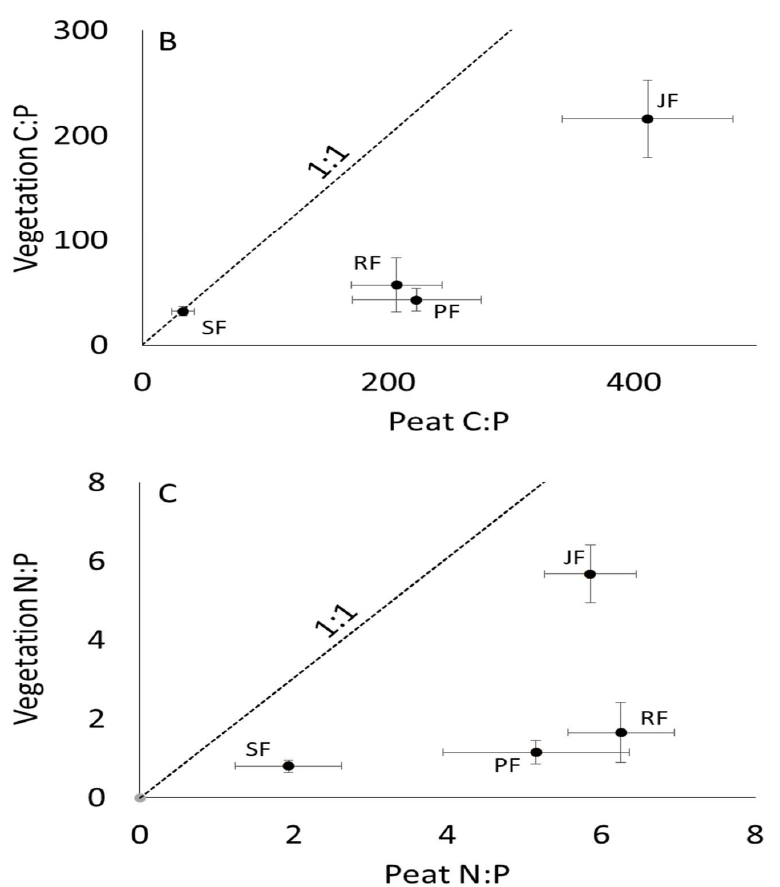
Figure 3. Resource and organism stoichiometry in ( A ) C:N, ( B ) N:P, and ( C ) C:P (all as g g − 1 ) across the four study sites (saline fen, SF; rich fen, RF; poor fen, PF; and Jacos fen, JF). C:N, N:P, and C:P ratios display a homeostatic trend across the four sites as per the approach of Sterner and Elser (2002), given that the strengthen of the relationship was not significant ( p > 0.05 throughout). Points and error bars are the mean and one standard deviation of 24 peat and 9 vegetation samples per site.